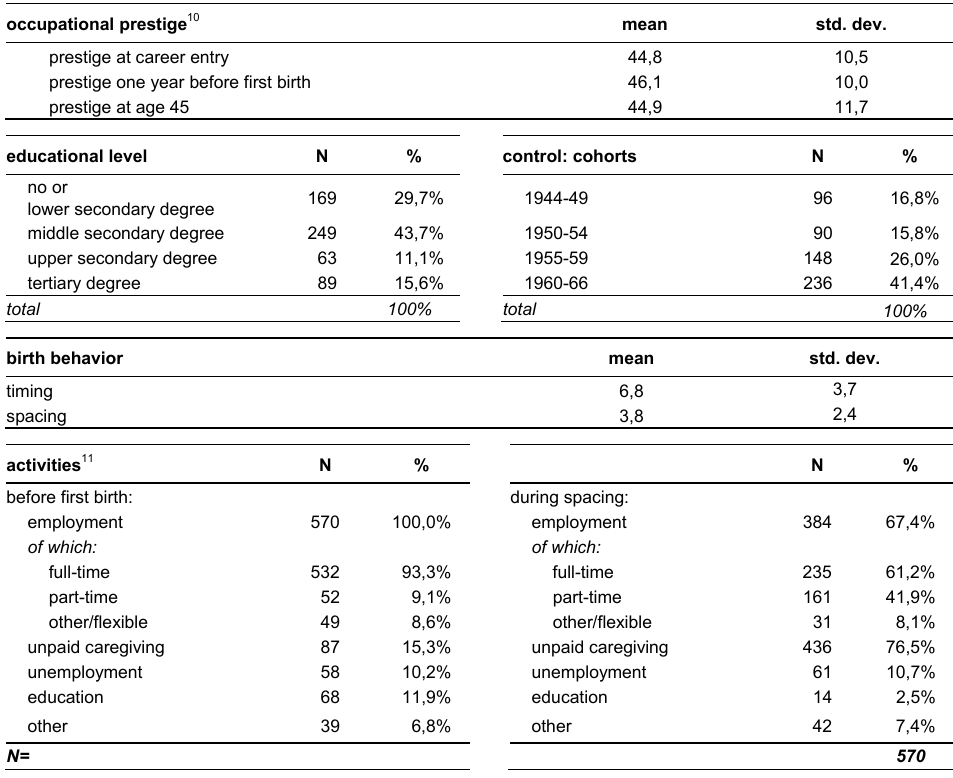
Table 2 : descriptive statistics to relevant variables to women’s career